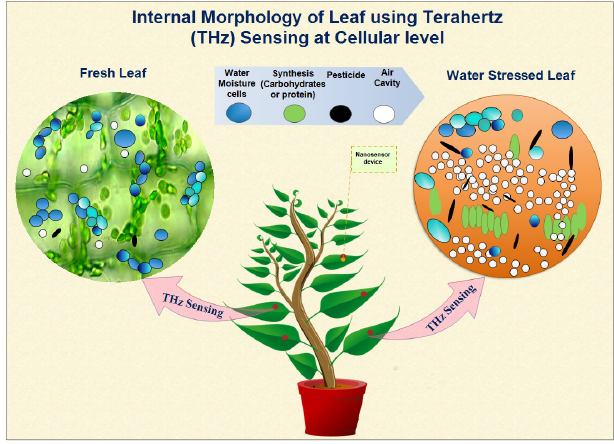
Figure 1. Internal morphology of fresh and water stressed leaf using THz